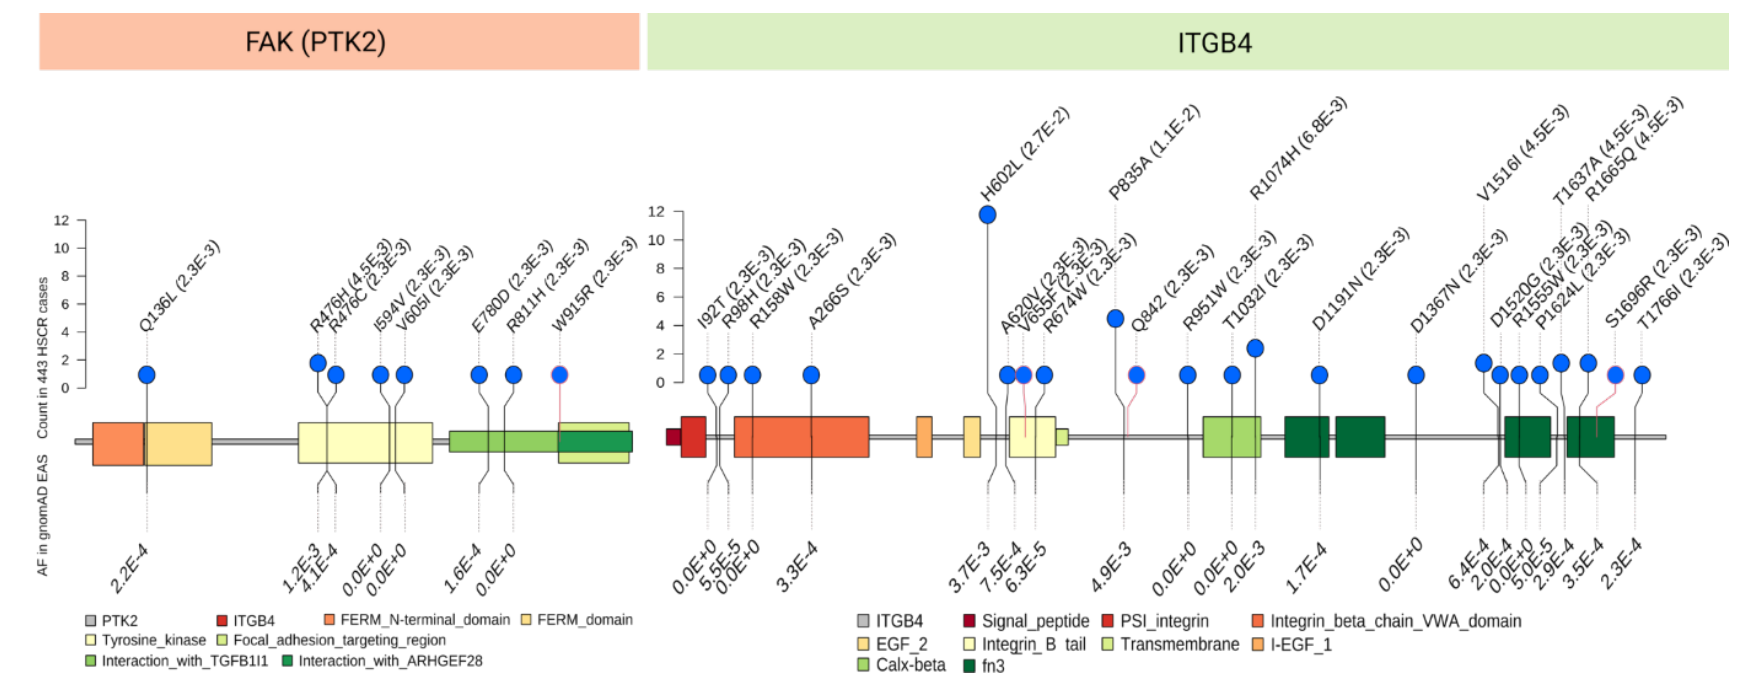
Figure 3. Mutation spectrum of the two genes ( FAK / PTK2 and ITGB4 ) with increased burden of rare damaging variants in S-HSCR cases (Data from Tang et al. [31]). Count of the variant is represented by the height of the lines with the blue dot, while the minor allele frequency is represented by the annotation in brackets following the protein mutation label on the top. The colour of the dot border represents whether this mutation is reported in the gnomAD database (black is reported and orange is novel) and the frequency in gnomAD East Asia is labelled at the bottom.